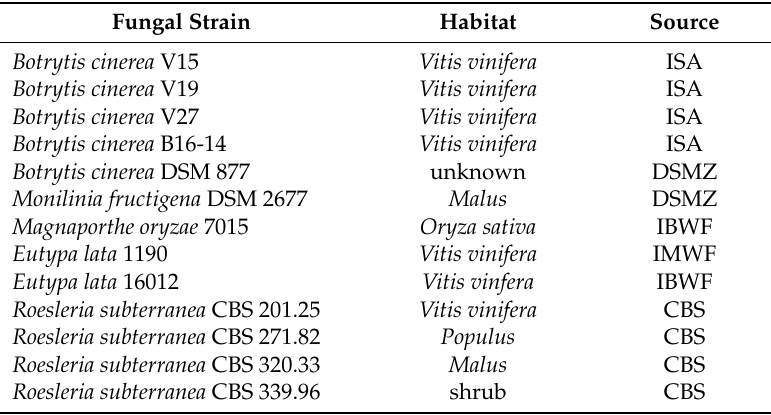
Table 2. Plant-pathogenic fungi used as target